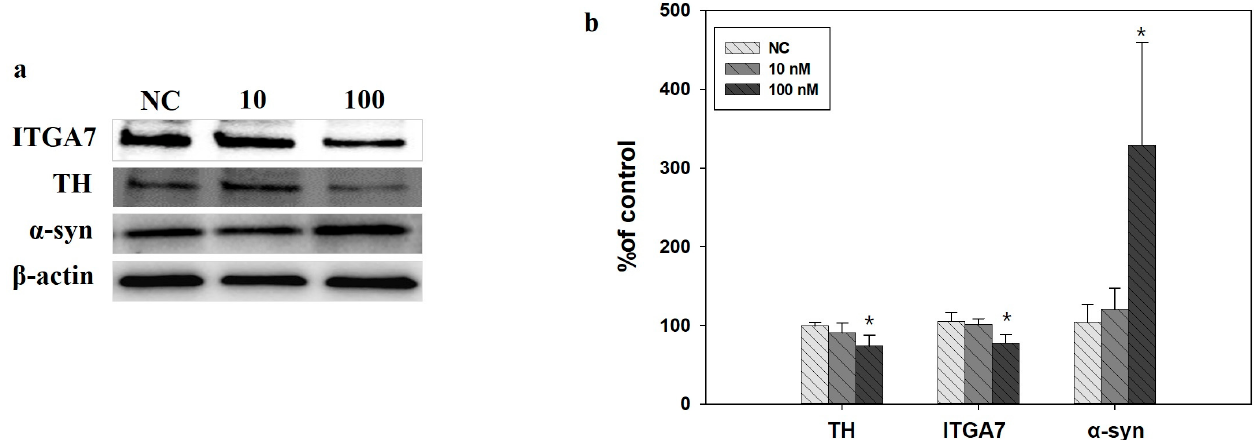
Figure 5. (a) Western immunoblot analysis showed that the administration of ITGA7 siRNA decreased ITGA7 and TH expression but increased α -synuclein ( α -syn) expression in the SH-SY5Y cells. ( b ) NC, negative control siRNA treatment (100 nM for 24 h); 10, ITGA7 siRNA treatment (10 nM for 24 h); 100, ITGA7 siRNA treatment (100 nM for 24 h). * denotes p < 0.05 compared to NC. All values are expressed as mean ± standard error, and statistical analysis was performed using ANOVA.